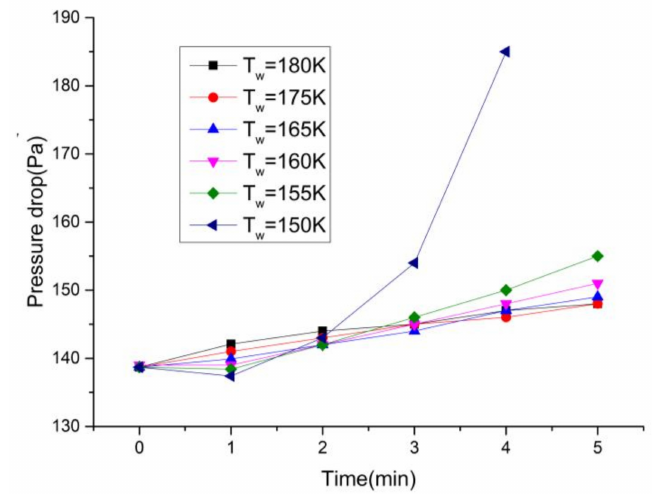
Figure 16. Pressure drop at different wall temperatures.